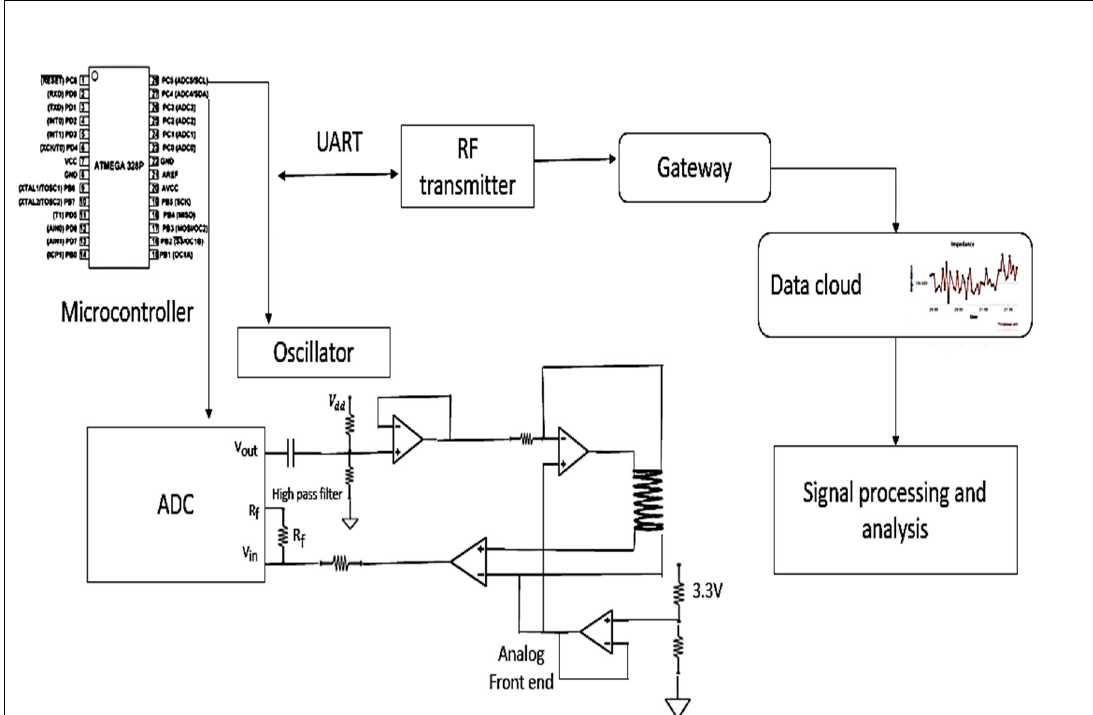
Figure 11. The block diagram of the design of the wireless MEC sensor.